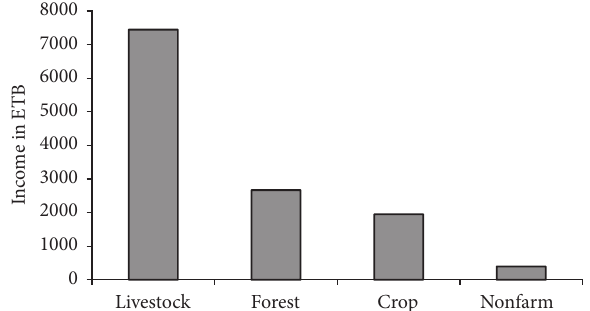
Figure 2: Major sources of annual household income and their contributions (in ETB) in the study